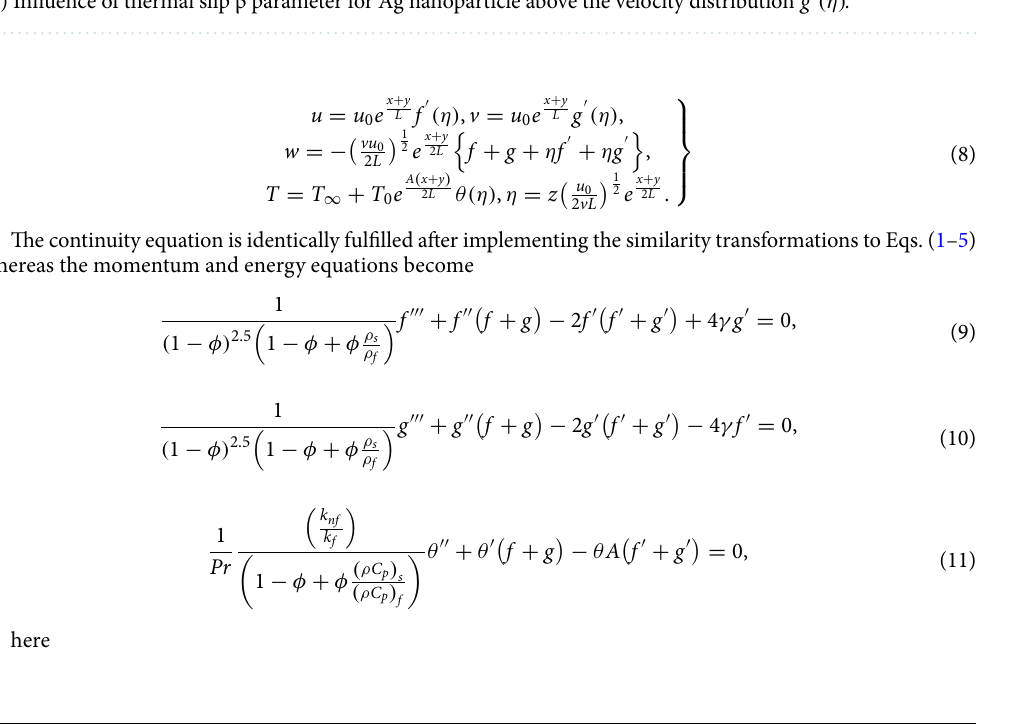
Figure 5. ( a ) Influence of thermal slip β parameter for CuO nanoparticle over the velocity distribution g ′ (η) . ( b ) Influence of thermal slip β parameter for Ag nanoparticle above the velocity distribution g ′ (η)